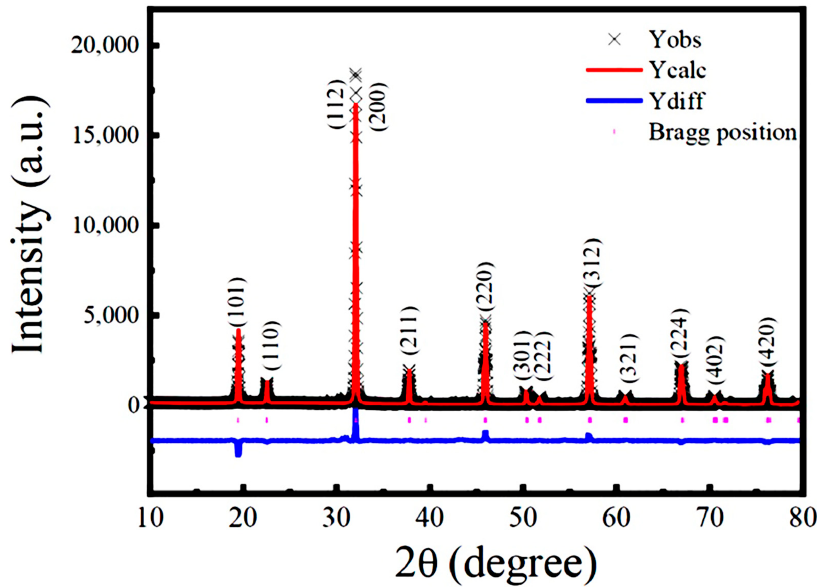
Table 1. Refined lattice parameters, selected bond length and bond angles, and the fitting parame- ters of the SFRO powders annealed at 1100 °C under N 2 atmosphere.